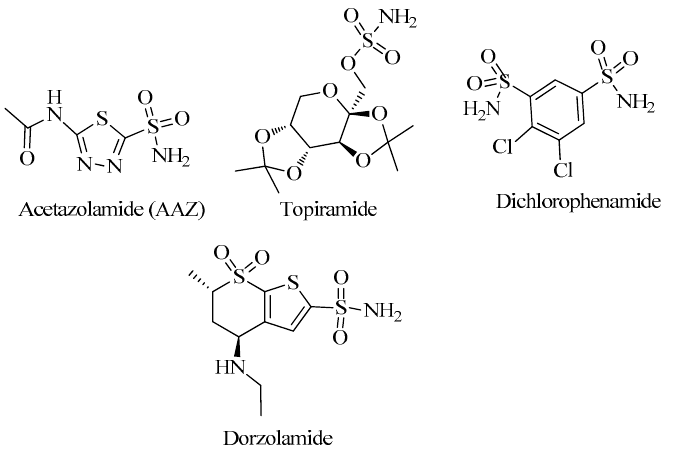
Figure 1. Known CA inhibitors.